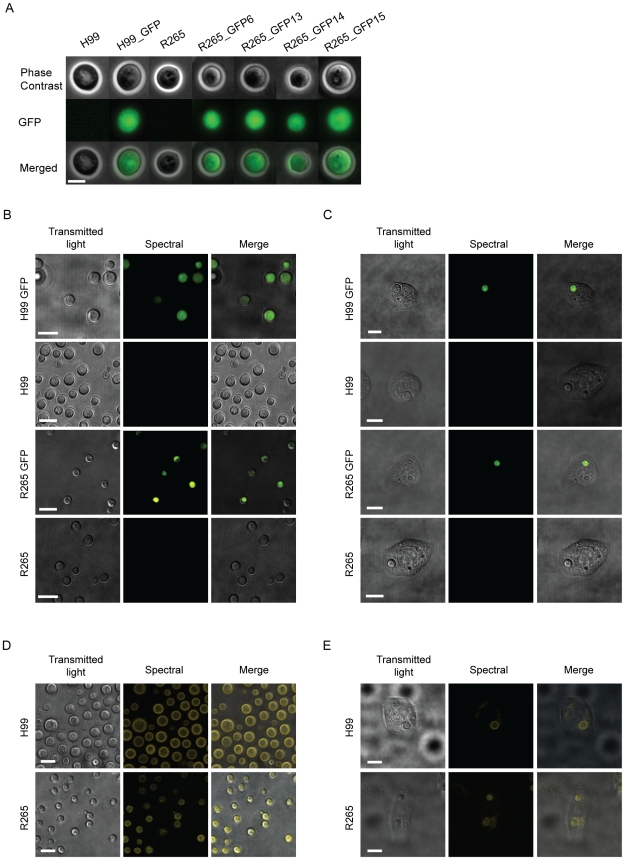
Imaging analysis of cryptococcal GFP fluorescence and autofluorescence.(A) GFP expressing strains exhibit a strong fluorescence signal that is absent in the parental strains. Epifluorescence images were captured and processed identically for each parental strain and transformant. (B and C) Spectral confocal images of parental strains and transformants showing absence of observable green fluorescence in parental strains when compared to the GFP expressing transformants either alone (B) or after phagocytosis by a macrophage (C). (D and E) Spectral confocal images of autofluorescence of parental strains either alone (D) or after phagocytosis by a macrophage (E). Spectral images were captured over 32 channels, 6 nm apart, between 500.1 nm and 691.3 nm. Spectral images images have been coloured to their actual fluorescent spectra. For separate channels of spectral images see Figures S2, Figures S3, Figures S4, Figures S5, Figures S6, Figures S7, Figures S8, Figures S9, Figures S10, Figures S11, Figures S12, Figures S13. Scale bars are 5 µm.